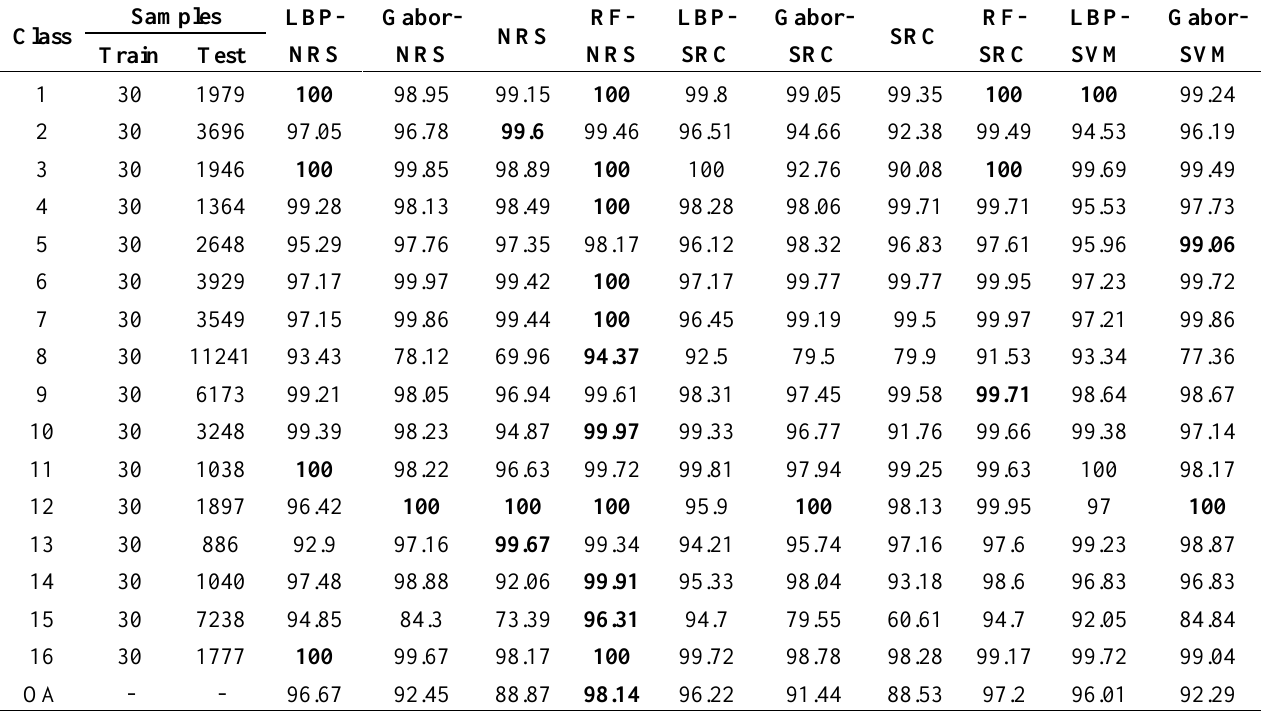
Table 7. Classification accuracy (%) for the Salinas dataset.